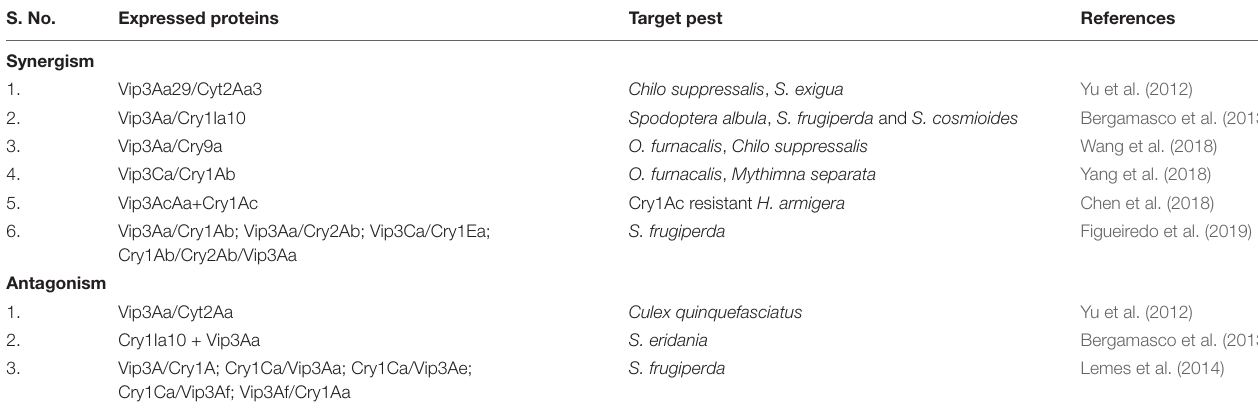
TABLE 4 | Synergistic and antagonistic behavior of Vip and Crystalline proteins. S.